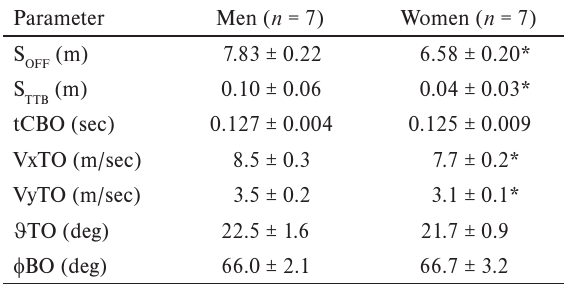
Results of performance, the touchdown on the board and take-off parameters (mean ± SD ) and of the statistical